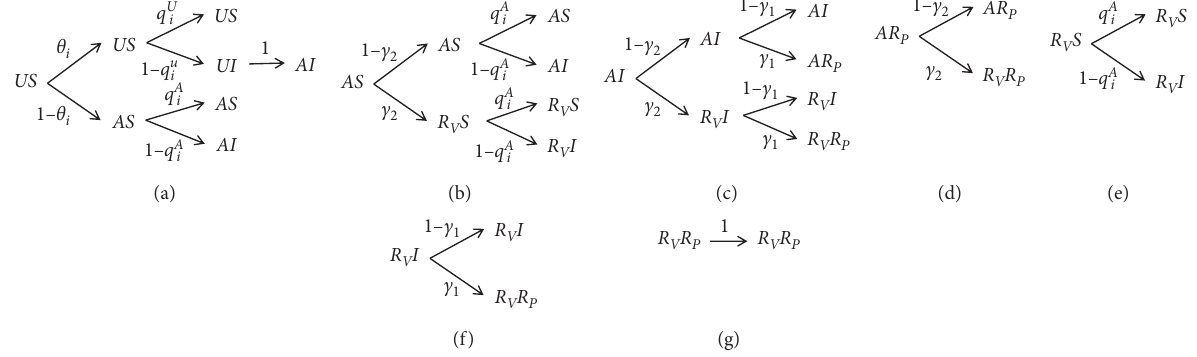
Figure 2: Transition probability trees for the seven possible states in the UAR-SIR